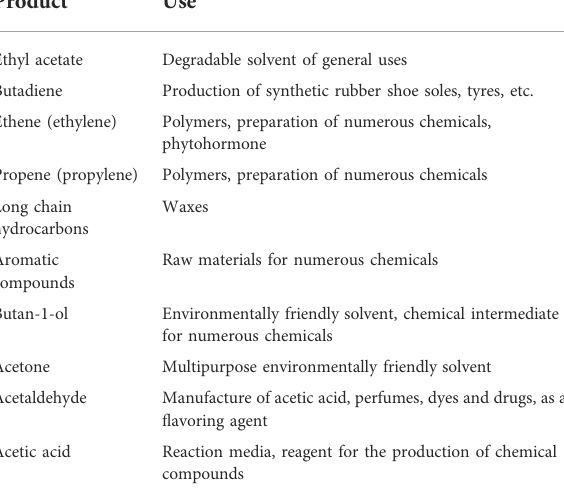
TABLE 4 Uses and applications of bio-derivatives from